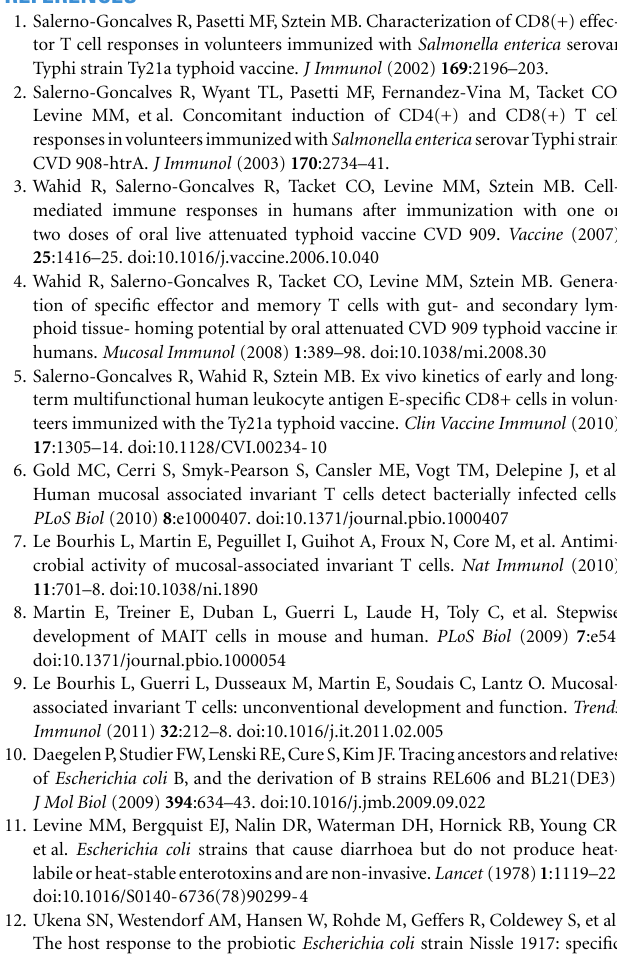
experiment (A) . (C) Uninfected (medium) or E. coli -infected B-LCLs ( E. coli ) were stained with normal rabbit serum, followed by secondary donkey anti-rabbit-PE antibodies and used as control (background control). (D) E. coli strain BL21 stained with rabbit anti-MR1 antibodies was used as an additional control to assess cross-reactivity of the MR1 antibodies with E. coli ). Numbers correspond to the % positive cells in the denoted quadrants. SSA, side scatter area. Data are representative of one of two replicates with similar results. Figure S4 | Listeria and MAIT cell activation .Target cells were left uninfected (none) or infected with either Listeria monocytogenes (MOI 1:1, 1:10, and 1:50) or E. coli strain BL21 (MOI 1:30).THP1, a human monocytic cell line, was used as a target cells. Percentage of MAIT cells producing cytokines (IFN- γ and TNF- α ) or degranulating (CD107a/b) was detected after 16–18h of co-culture with uninfected or infected-B-LCL targets by flow cytometry. Data are representative of two experiments. Figure S5 | B cells activated MAIT cells in a dose dependent manner . B-LCL cells were left uninfected (none) or infected with either Salmonella typhi (MOI 1:3 and 1:30) or E. coli strains HS (MOI 1:30 or 1:100). (A) Percentage of B-LCL cells expressing bacterial antigens on their surface were measured by flow cytometry.Targets infected with E. coli or S. typhi were stained with antibodies to E. coli or CSA, respectively. (B) Percentage of cytokine-secreting MAIT cells after 16–18h of co-culture with uninfected or infected-B-LCL targets. Cytokine production by MAIT cells was evaluated by flow cytometry. Data are representative of five